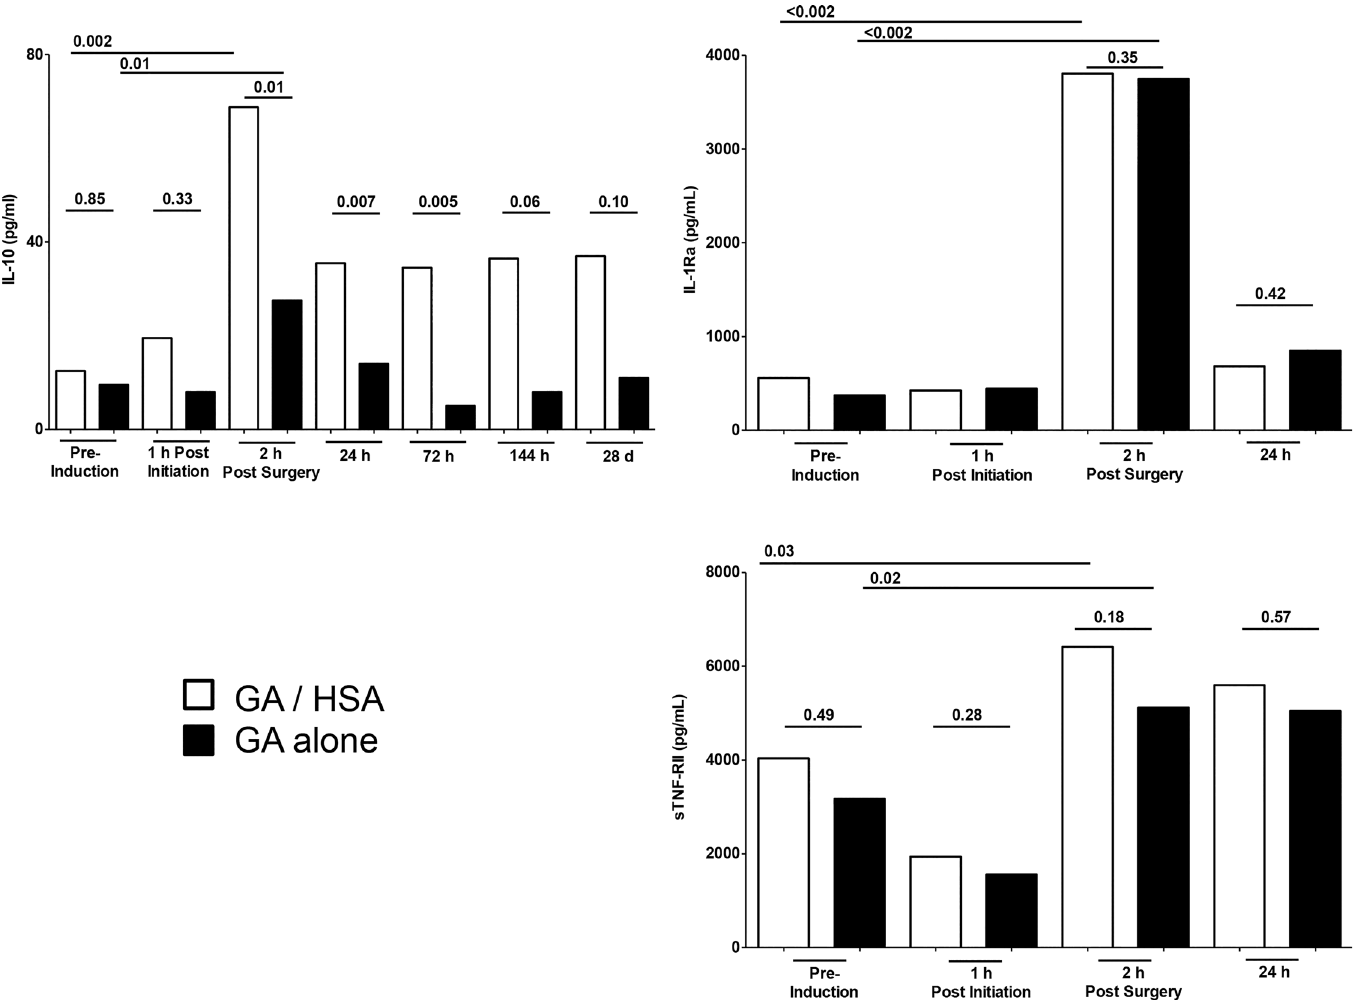
Fig 4. Anti-inflammatory responses of individuals receiving supplemental HSA. Median values are shown for HSA plus general anesthetic (open bars) vs general anesthetic alone (solid bars). P values reflect inter-group Mann Whitney comparisions at the time points